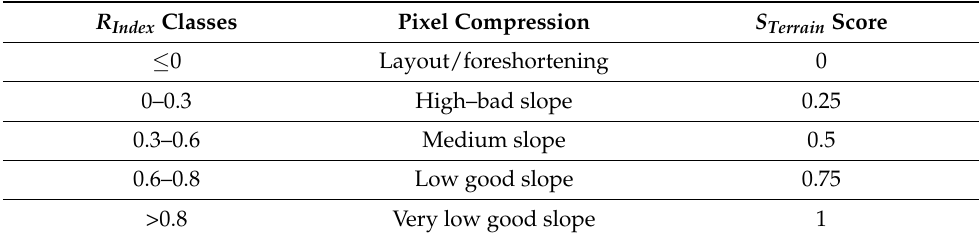
Table 2. The assessment rules of the R Index .